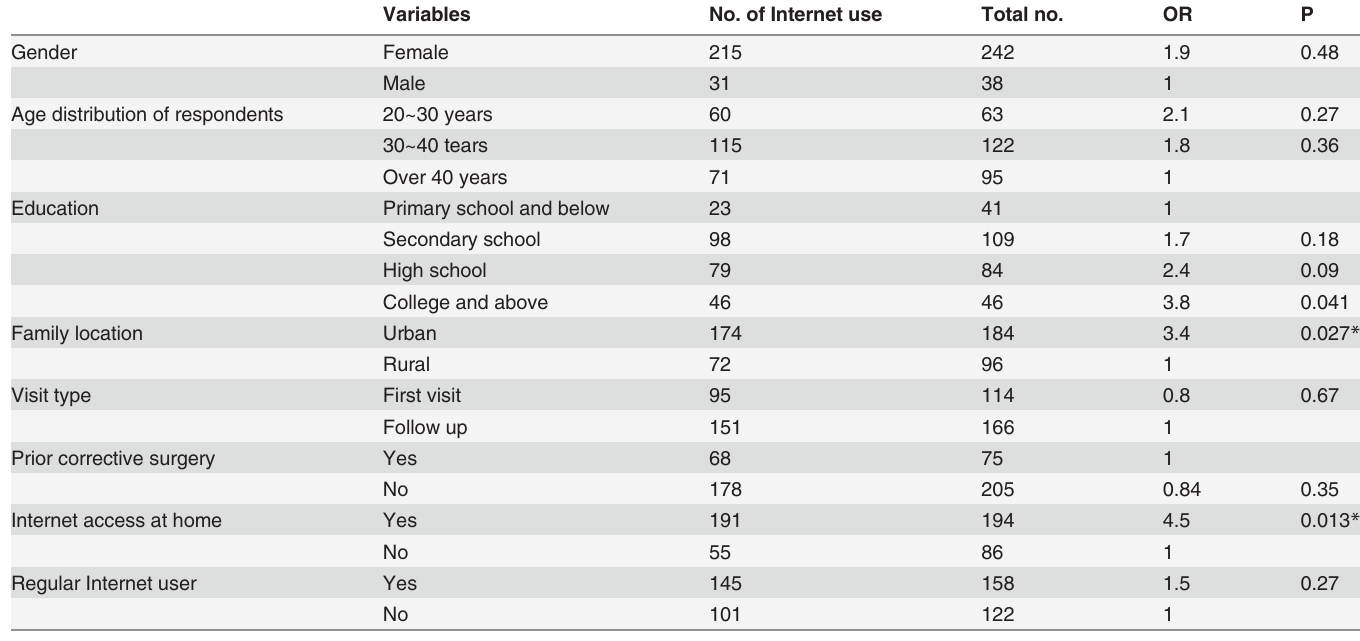
Table 4. Binary logistic regression model for the use of the Internet as a source of scoliosis related information.